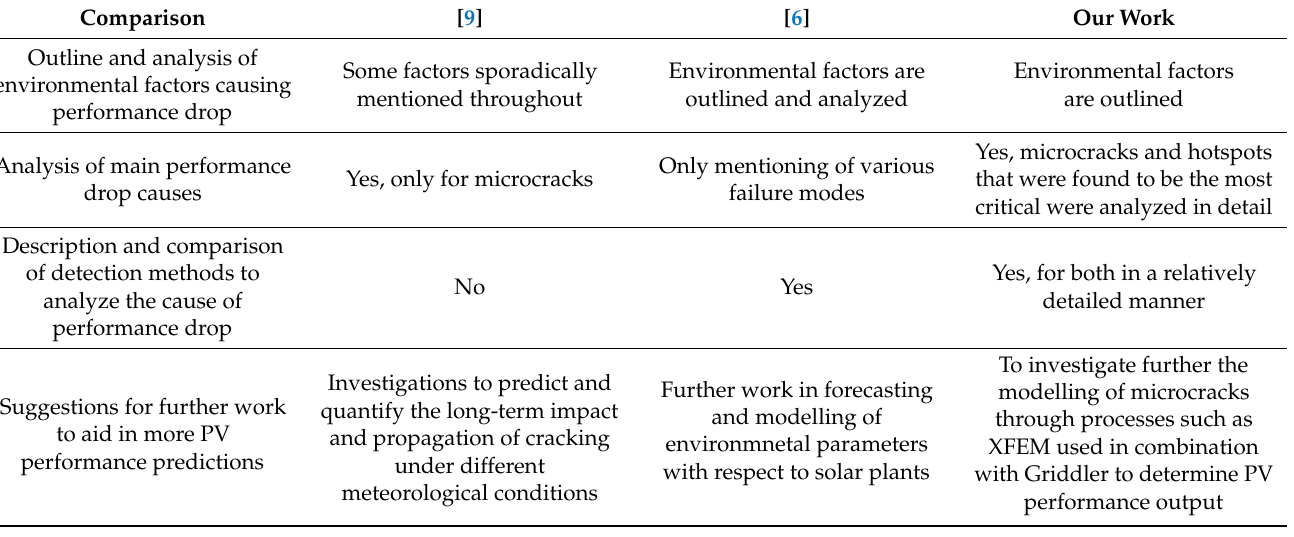
Table 5. Comparative study of our work compared with previously published